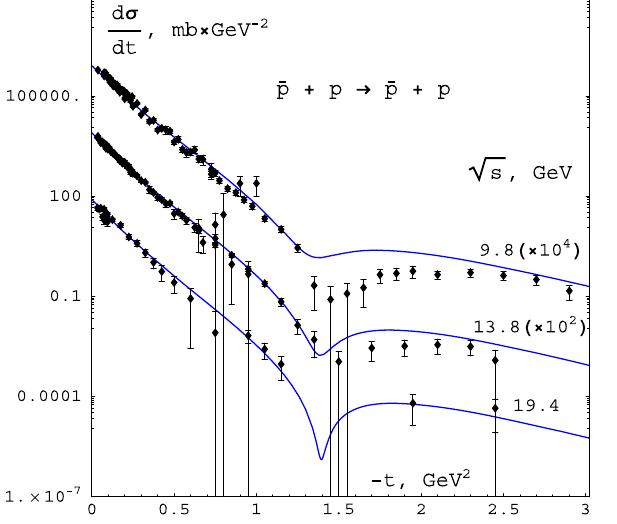
Fig. 5 The ¯ p p EDS angular distributions is the HP Regge residue, β